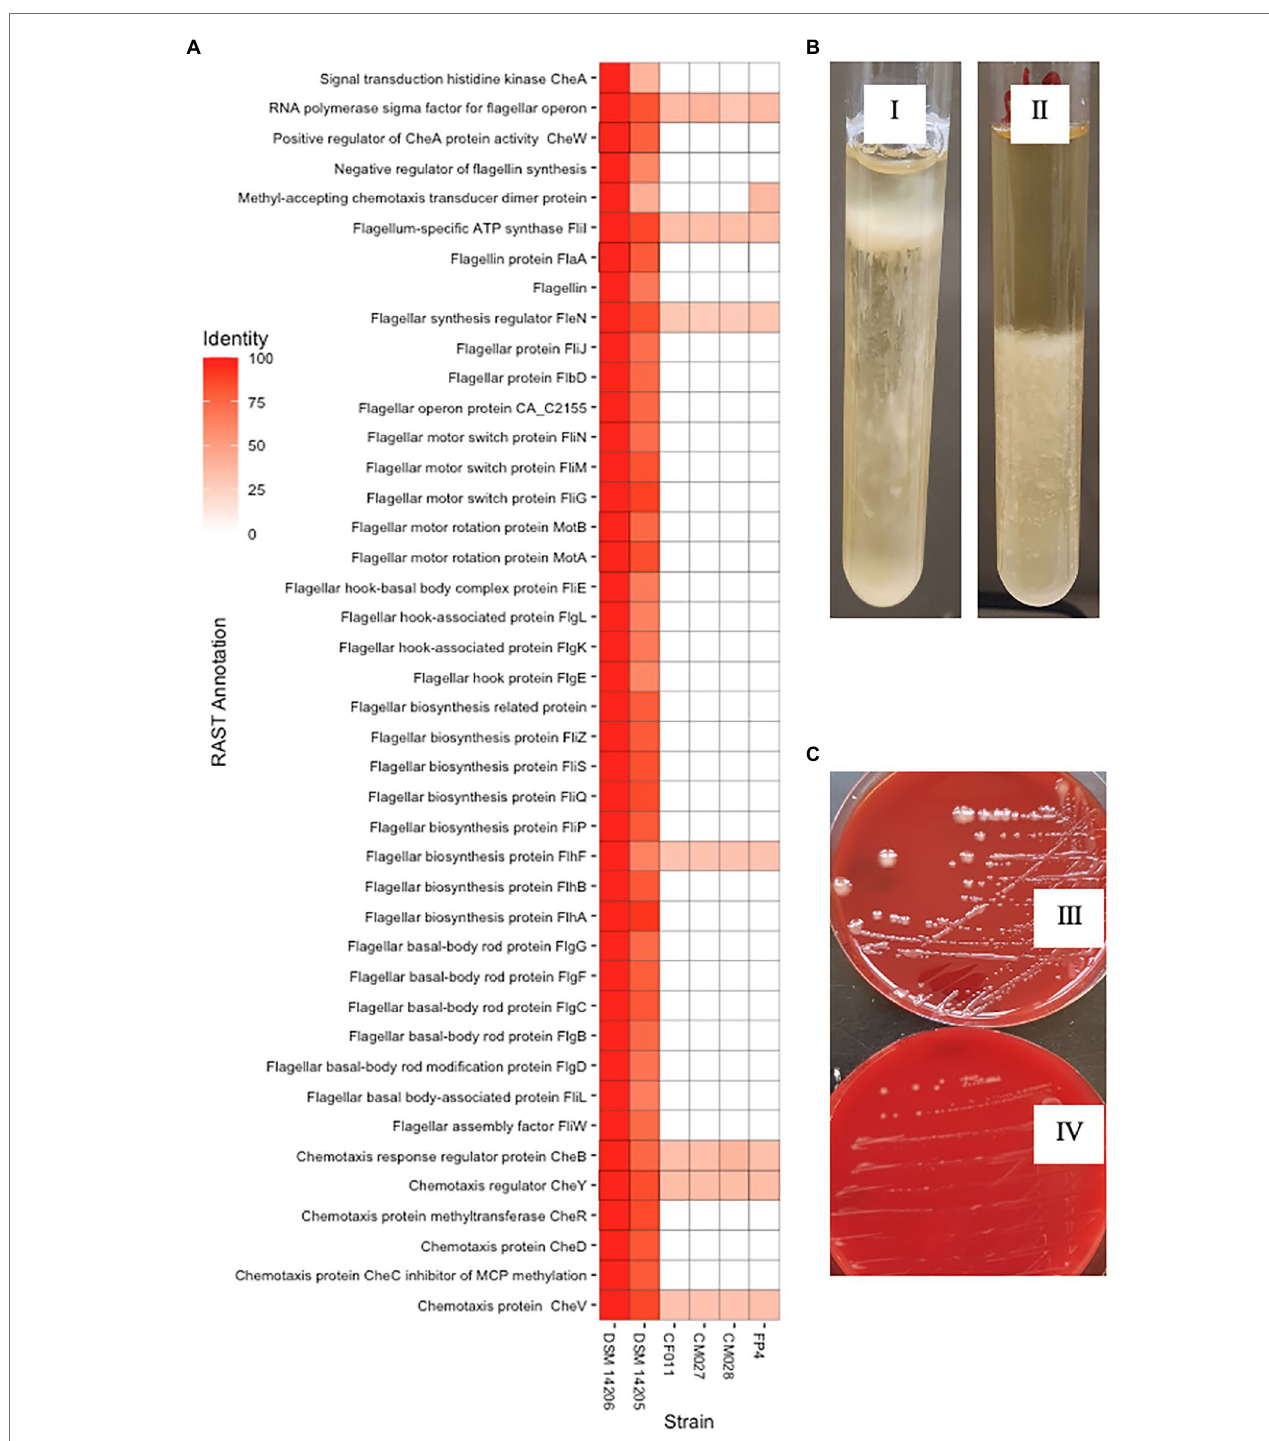
FIGURE 4 | Unique genotypic and phenotypic characteristics of genomospecies2. (A) Whole-genome sequence-based comparison in RAST server of genomospecies2 strains FP4, CF011, CM027, and CM028 against Clostridium bowmanii DSM 14206 and Clostridium lacusfryxellense DSM 14205 reveals the lack of flagellar assembly and signaling genes in genomospecies2. (B) Motility test in Reinforced Clostridium Media broth shows genomospecies2 CF011 has reduced motility compared to C. bowmanii DSM 14206. Both strains were incubated for 14 days without shaking. (C) On Columbia Blood Agar plates, genomospecies2 CF011 forms larger and slimy colonies unlike C. bowmanii DSM 14206. Both strains were incubated for 8